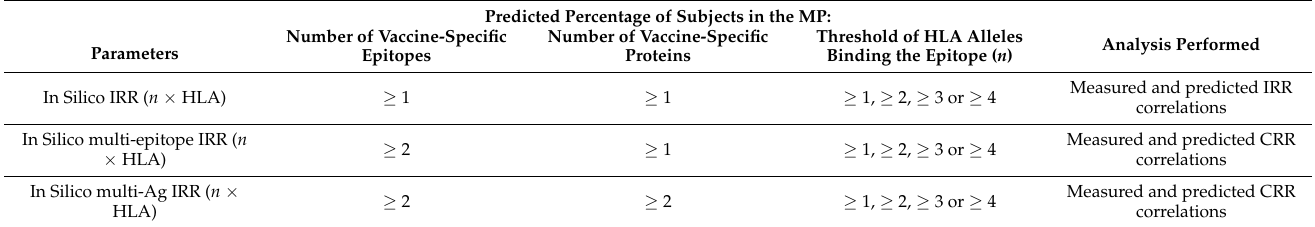
Table 2. Parameters used in the correlative